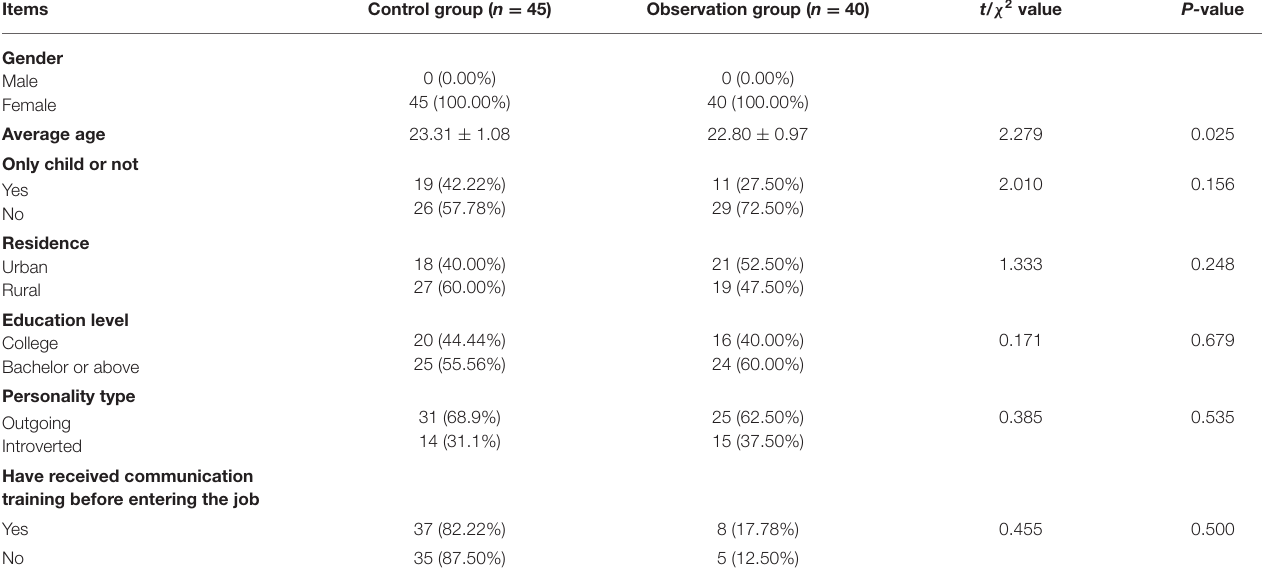
TABLE 1 | General information of new